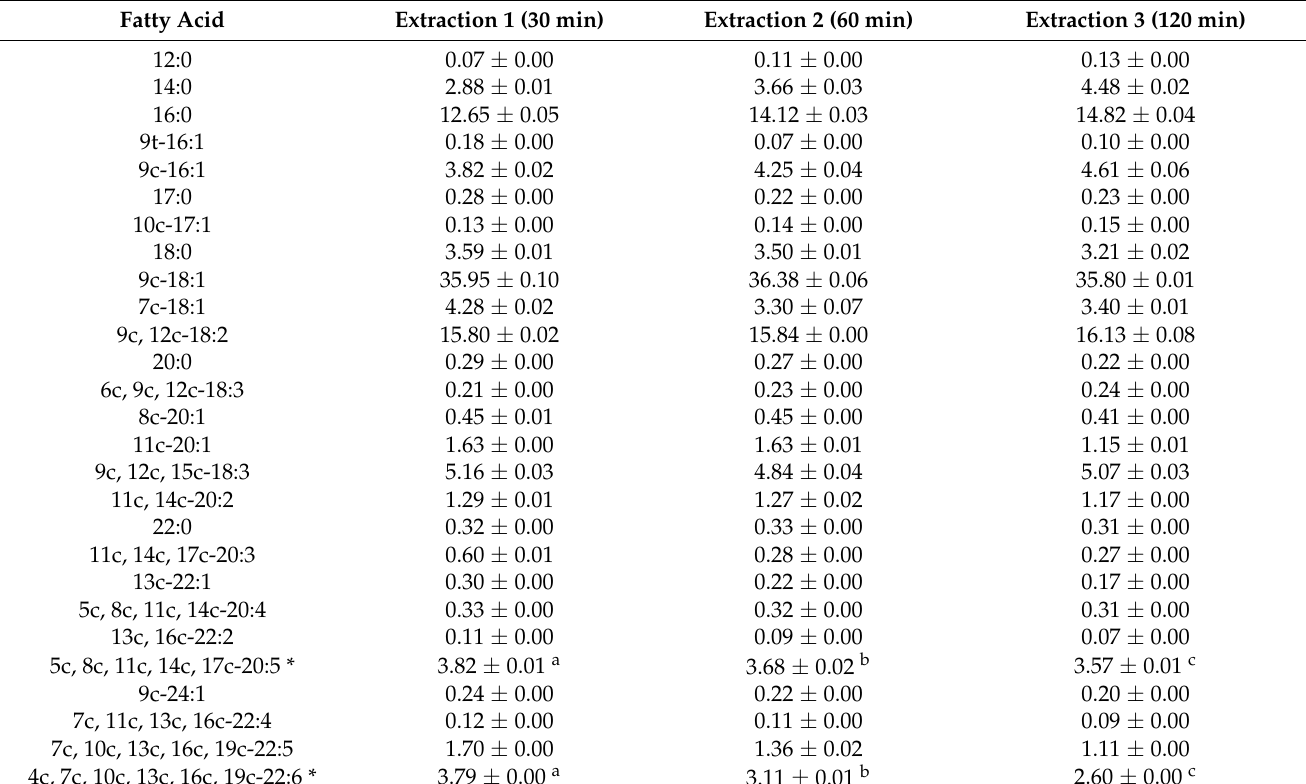
Table 4. FA composition and quantification (g/100 g TFA) of sAG extractions realized during lipase catalysis under CO 2